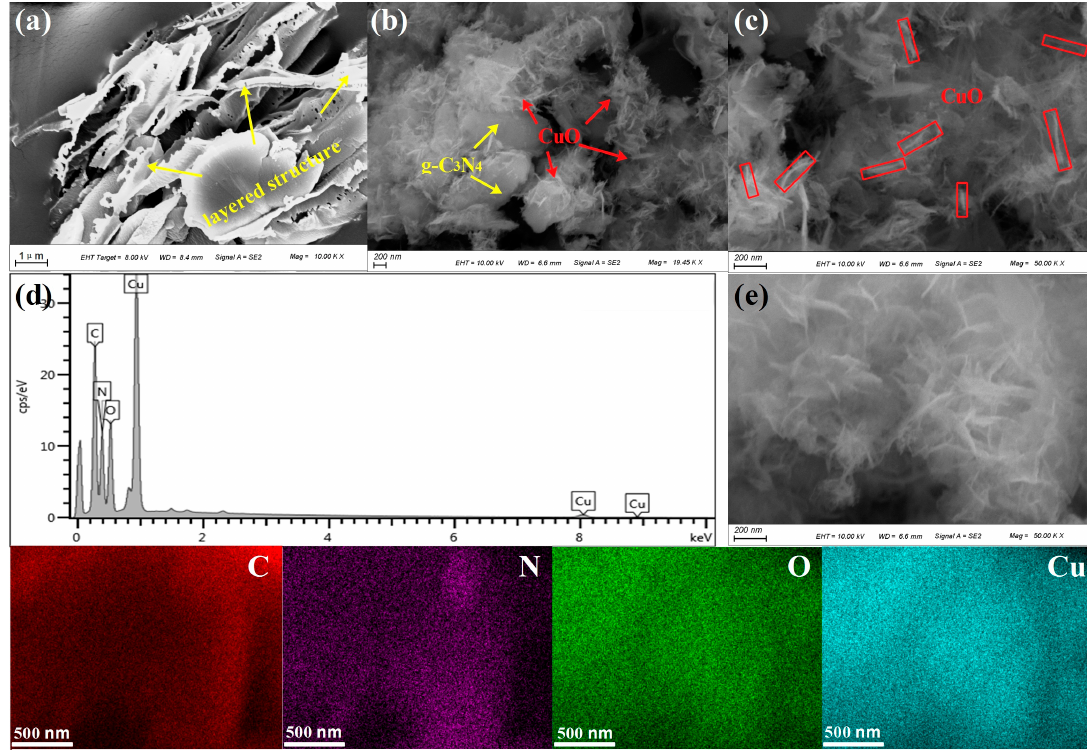
Figure 3. Field emission scanning electron microscopy (FESEM) images of ( a ) pure g-C 3 N 4 , ( b , c